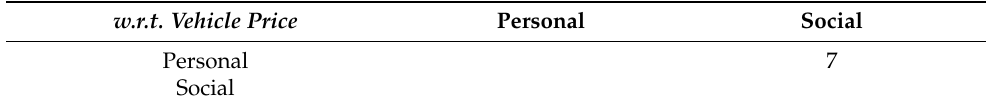
Table 6. Pairwise comparison matrix of PERSONAL and SOCIAL with respect to sub-criteria of COST of